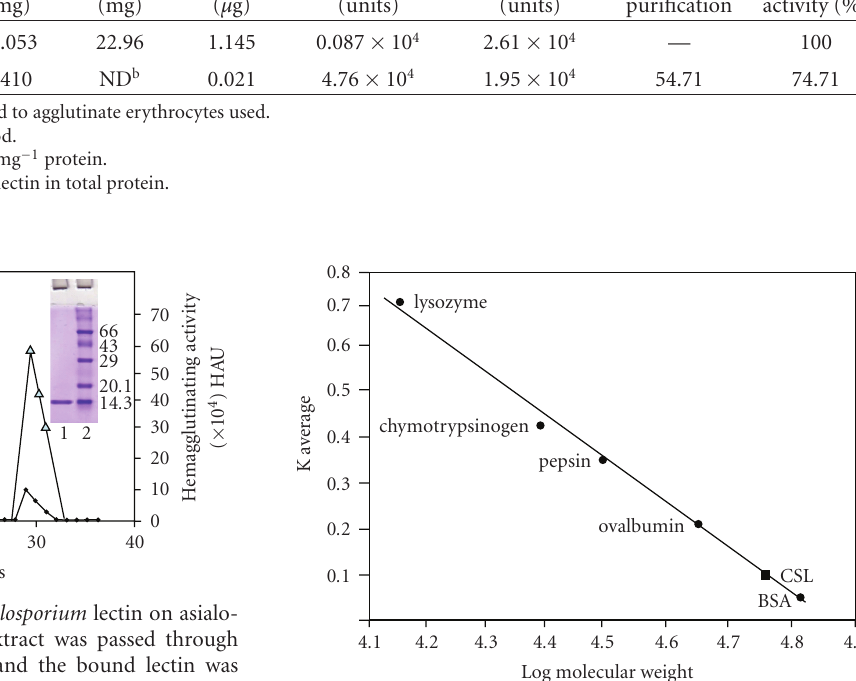
Figure 2: Calibration curve for the estimation of molecular weight of CSL by gel filtration chromatography. X -axis represents the log molecular weight and Y -axis represents K average, marker proteins; BSA (66kDa), ovalbumin (45kDa), pepsin (34.7kDa), chymotrypsinogen (25.6kDa) and lysozyme